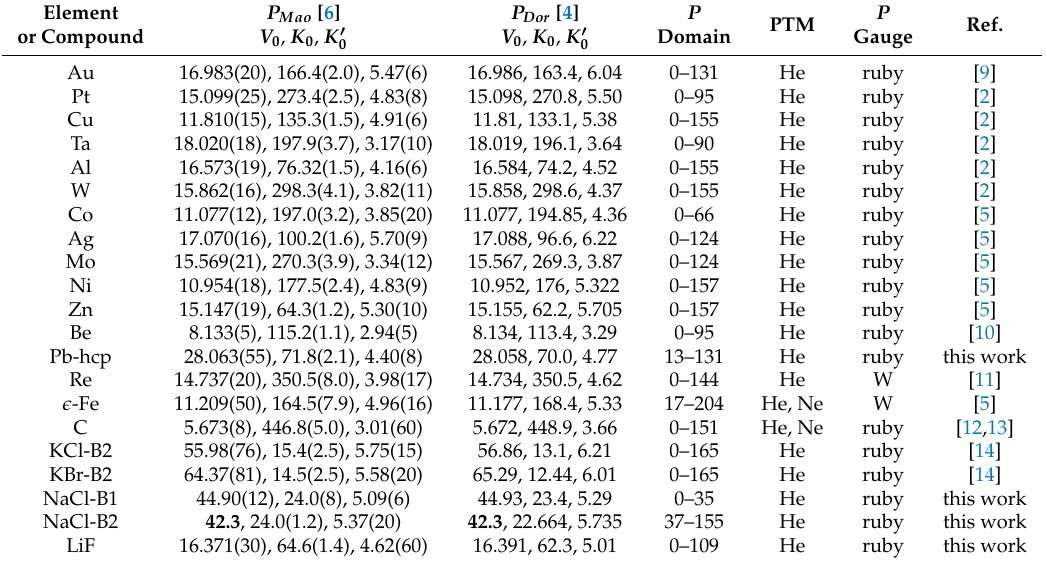
Table 1. Rydberg–Vinet [8] equations of state (EoS) parameters at 300 K for elements and compounds obtained by fitting of the P - V data. P Mao ( P Dor ) indicates that the ruby calibration has been taken from [4,6]. W gauge has been calibrated against ruby in [2]. PTM: pressure transmitting medium. V in Å 3 /at or /formula unit, P and K 0 in GPa. The numbers in bold have been fixed during the fit. The number in parenthesis indicate fit error bars (95% confidence level). They are of the same value in the third column as in the second column and are not reported. The reference for the published data is provided in the last